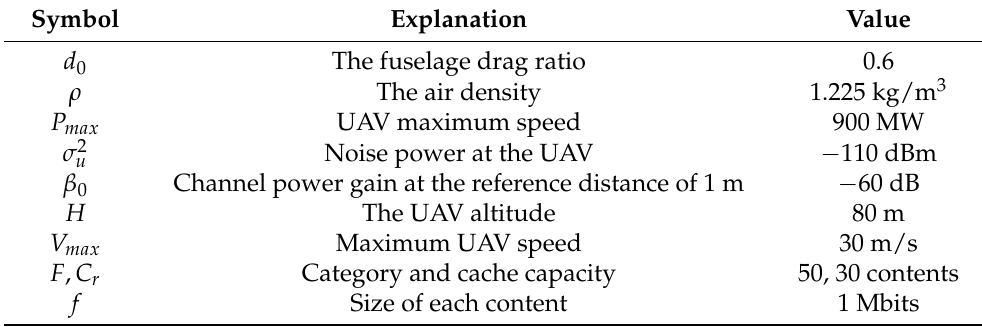
Table 1. Simulation parameters.